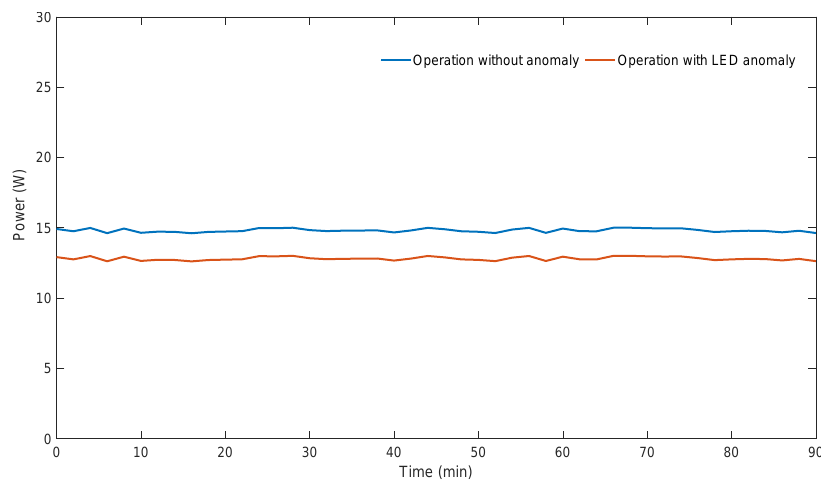
Figure 4. Power profiles of a lamp for anomalous and anomaly-free